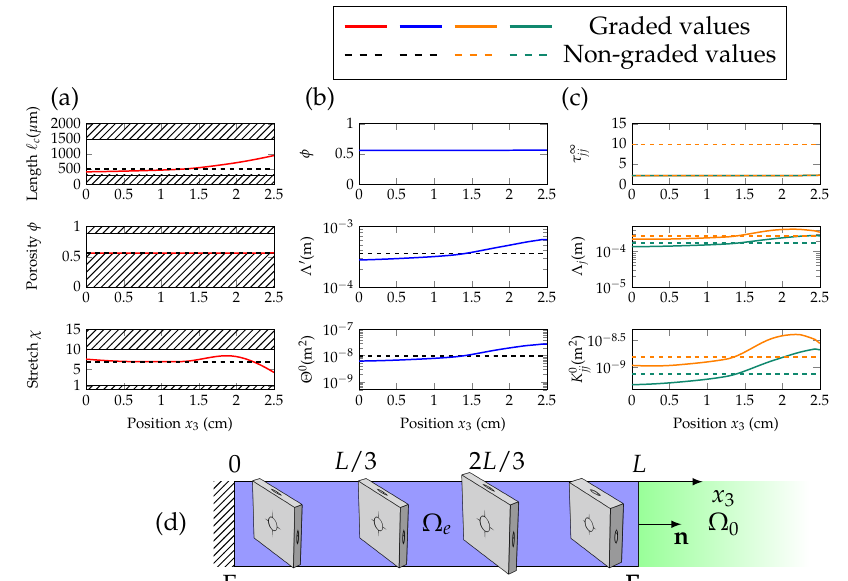
Figure 5. Components of the vector of geometric parameters W g (characteristic length (cid:96) c , porosity φ and stretch χ ) are shown in ( a ), as a function of the position x 3 . Scalar Johnson–Champoux–Allard–Lafarge (JCAL) parameters ( φ , Θ 0 , Λ (cid:48) ) are given in ( b ) and the direction-dependent ones ( τ ∞ ⊥ , τ ∞ , K 0 ⊥ , K 0 , Λ ⊥ , Λ 3 ) are in ( c ), with respect to x 3 . The graded values 33 33 are in solid lines, and the non-graded ones in dashed lines; in orange for the normal direction, and in green for the transverse direction. The sketch in ( d ) displays snapshots of the unit cells at intervals of L /3 between interfaces Γ 0 and Γ L .